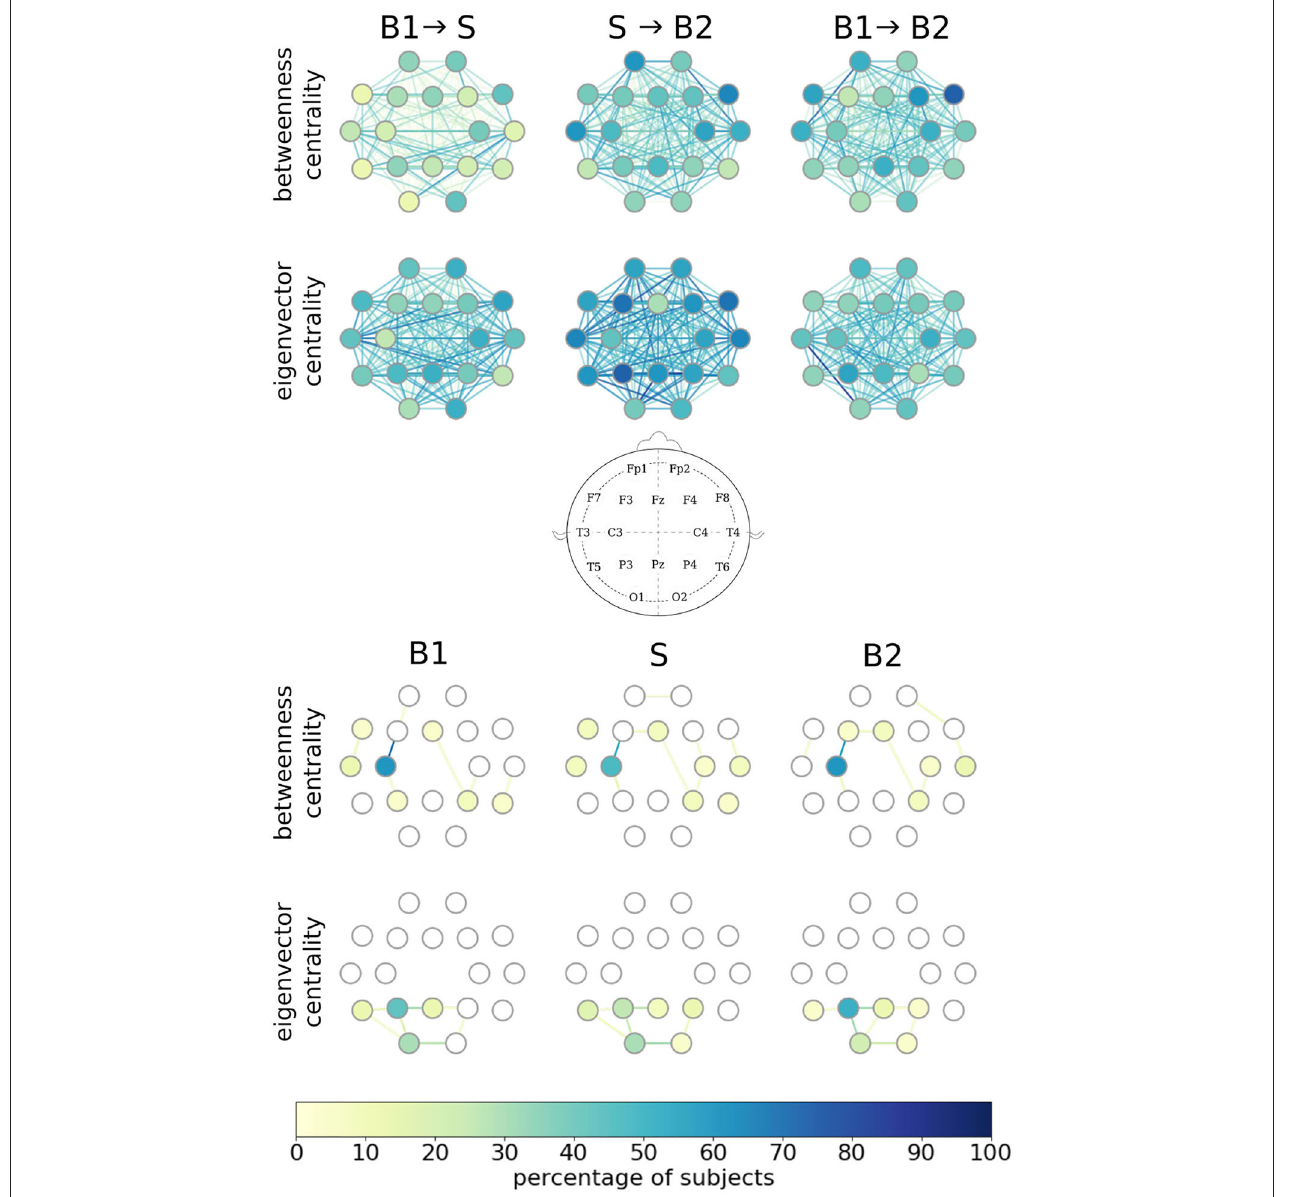
FIGURE 2 | Alterations in local network characteristics when functional brain networks transit from the baseline (B1) to the taVNS stimulation phase (S) and back to the baseline (B2). Network vertices arranged according to the international 10-20 system for EEG recording (middle plot). (Top) Vertices and edges with significant stimulation-induced changes of their betweenness/eigenvector centralities. Color coding of individual network constituents according to the percentage of subjects for whom we obtained significant changes in vertex/edge centralities on a per-subject base. (Bottom) Most important vertices and edges during phases B1, S, and B2. Importance estimated with vertex/edge betweenness/eigenvector centrality. Color coding of individual network constituents according to the percentage of subjects for which the constituent was most